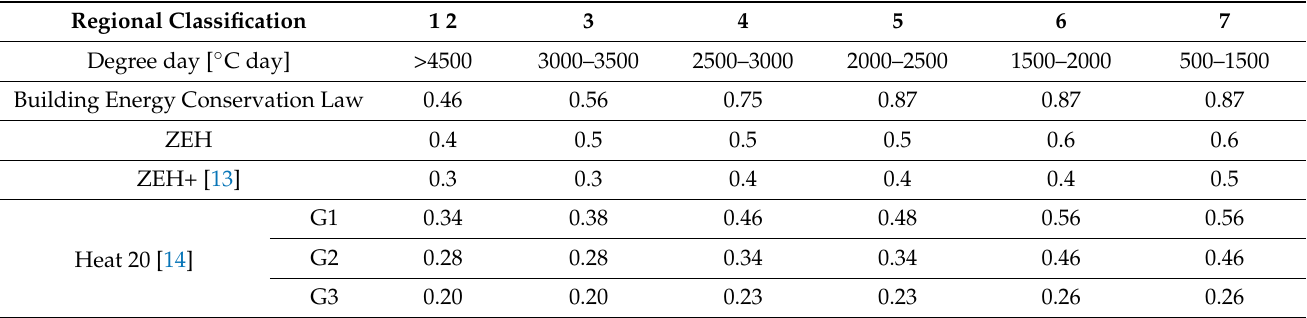
Table 1. U A value of the national standard in Japan and